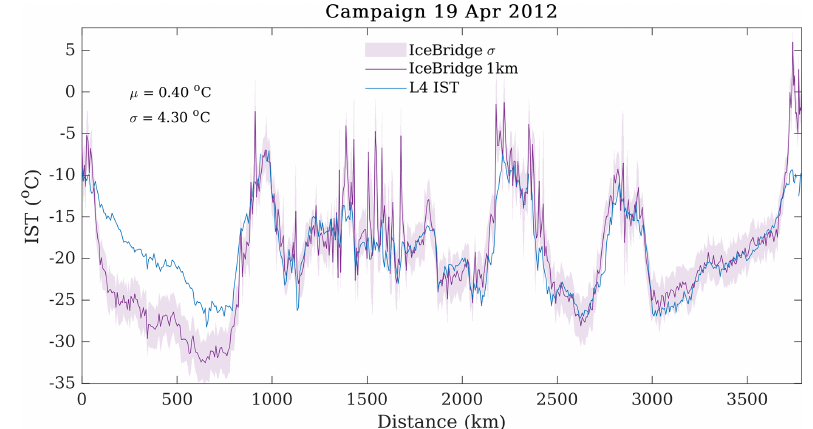
Figure 8. IceBridge 1km averaged IST on 19 April 2012 (magenta) and standard deviation (shaded area) along with the corresponding L4 IST values